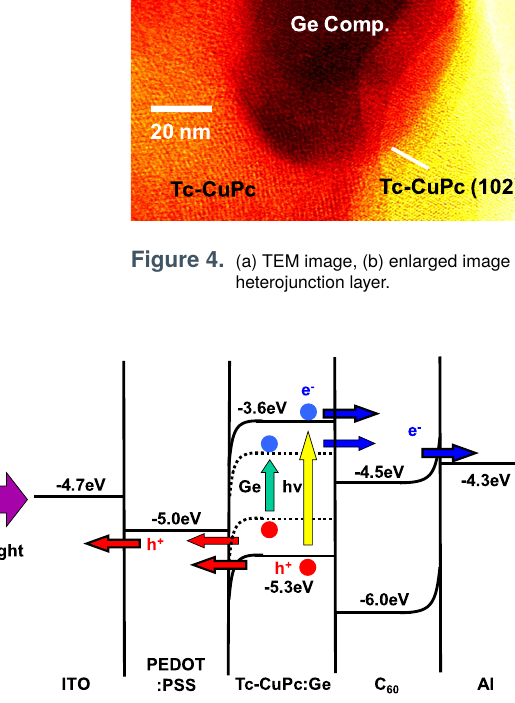
Figure 5. Energy level diagram of Tc-CuPc:Ge/C 60 solar